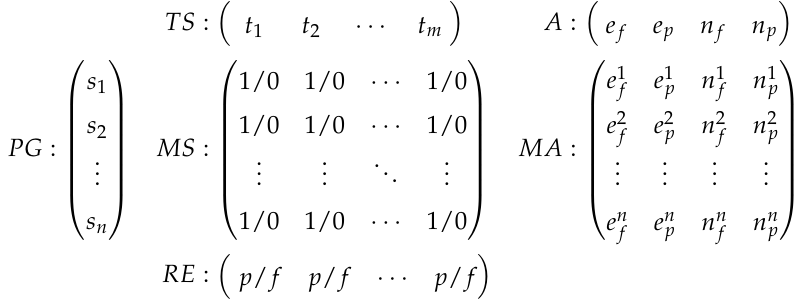
Figure 1. Essential information for